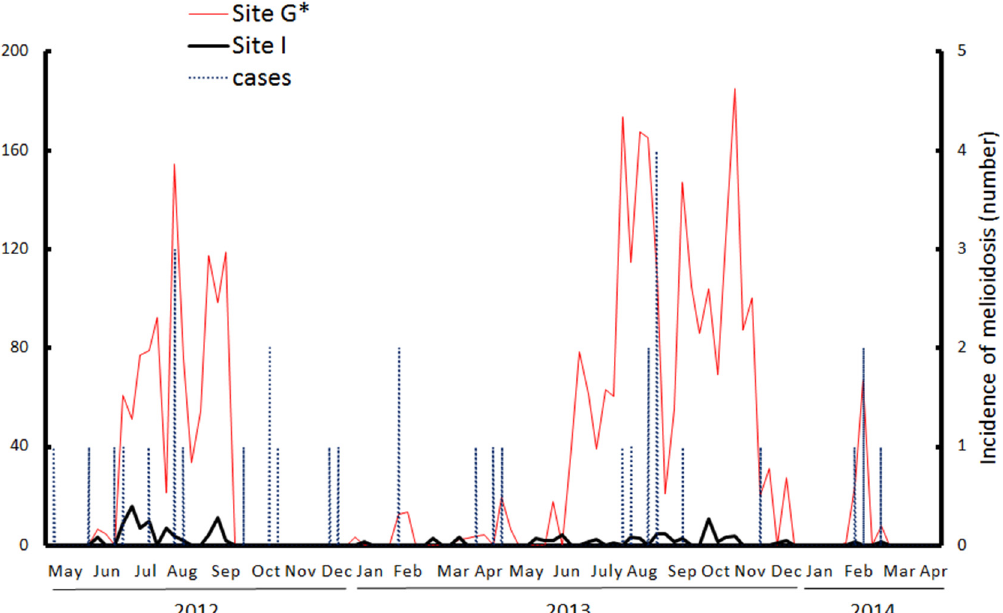
Fig 4. B. pseudomallei -specific DNA concentration and melioidosis cases. From May 2012 to April 2014, the B . pseudomallei -specific DNA concentration was measured from the total air particles collected from Sites G (red line) and I (black line) (location see Fig 1). The melioidosis cases (blue dotted line) are shown. The symbol ( * ) indicates the correlation between contaminated aerosols and the melioidosis incidence.